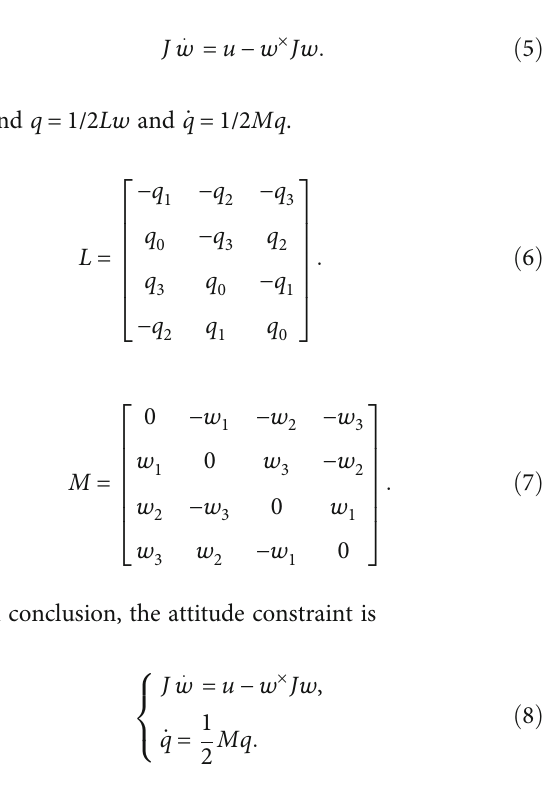
Table 1: Spacecraft operating